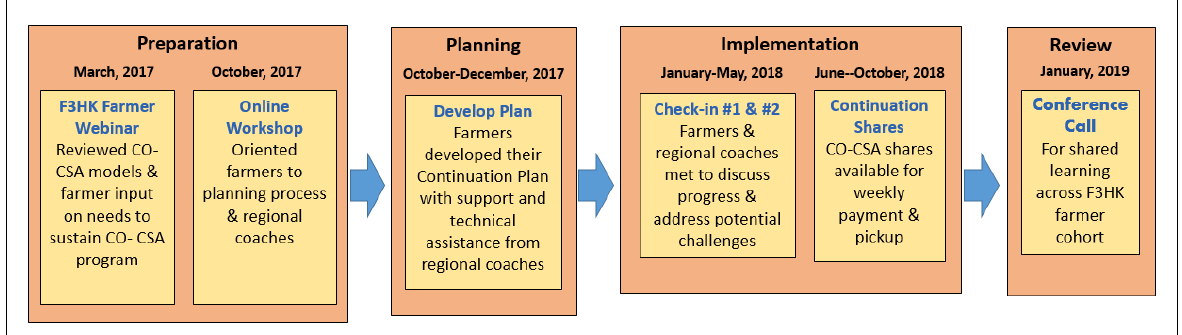
Figure 1. CO-CSA Continuation Planning Process for F3HK